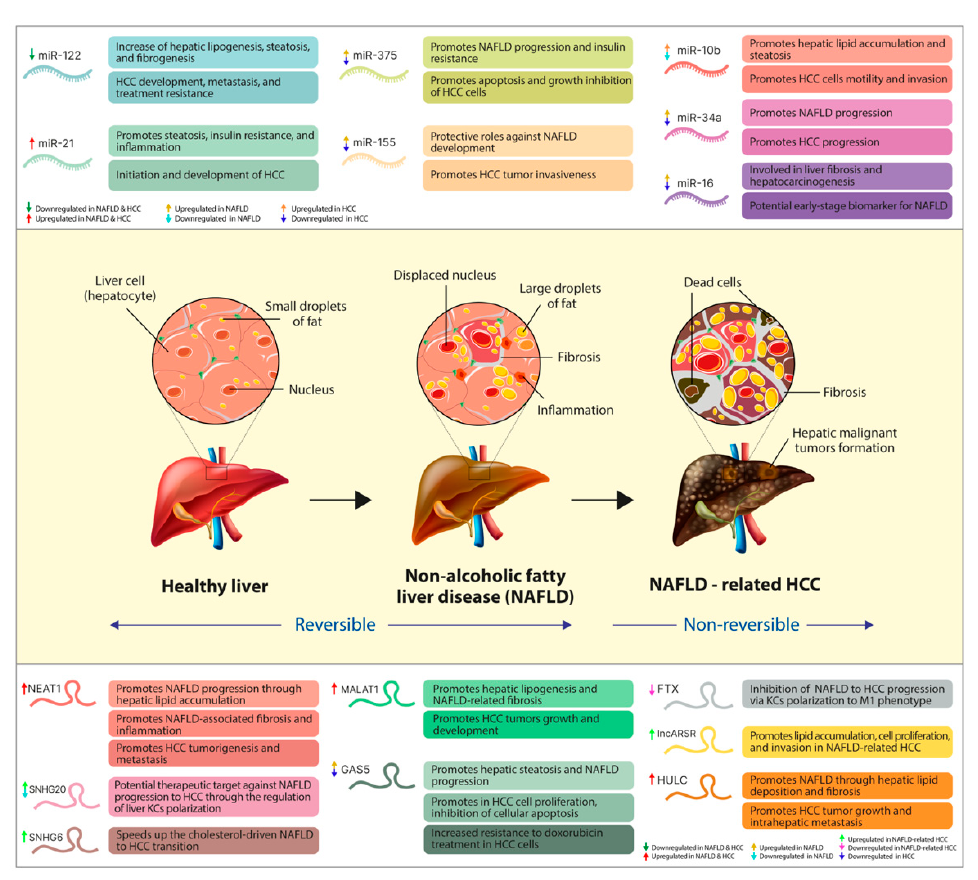
Figure 2. The pathologic transition of healthy liver towards NAFLD-related HCC, together with the main dysregulated ncRNAs and the disease-promoting processes they regulate. In the upper part of the figure, we illustrated the primary miRNAs and their expression pattern throughout the transition of NAFLD towards HCC, together with the pathological processes of which regulation they play a part in. Centrally, we summarize the main changes in the cellular and tissue architecture of the liver in both NAFLD (reversible) and NAFLD-related HCC (nonreversible). At the bottom, we presented the main lncRNAs involved in NAFLD transition towards HCC, their dysregulated expression level, and the main disease-promoting process in which they play a regulatory role.